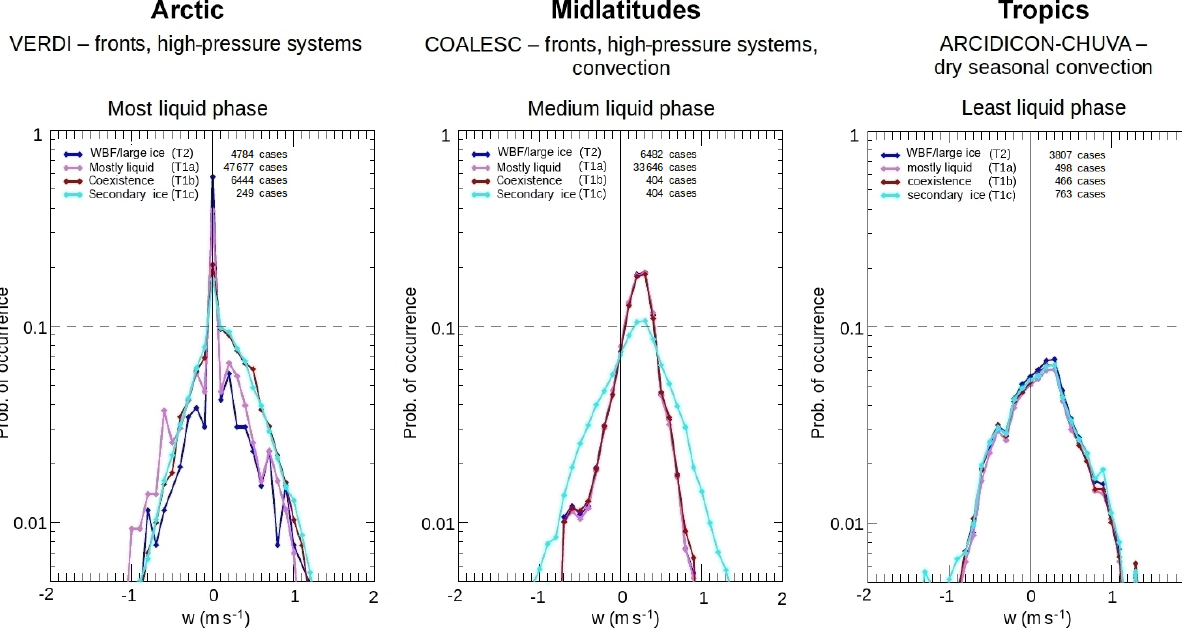
Figure 12. Frequency of occurrence for vertical velocities ( w ) within mpt clouds during the campaigns VERDI (Arctic), COALESC (mid- latitudes) and ACRIDICON–CHUVA (tropics) for the different cloud types ( T